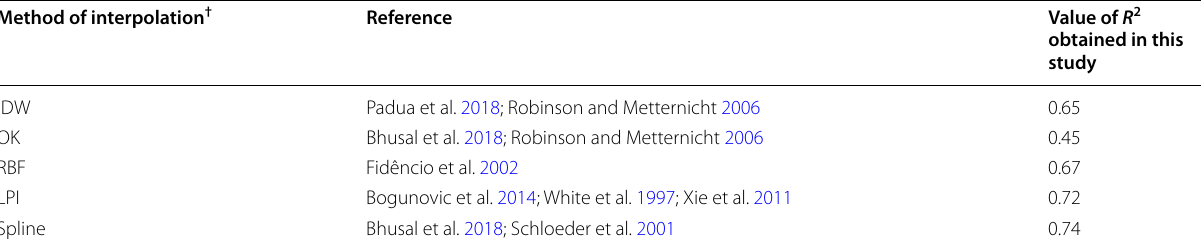
Table 3 Coefficient of determination ( R 2 ) estimated for different spatial interpolation methods with respect to the relationship between the observed and corresponding predicted SOC values